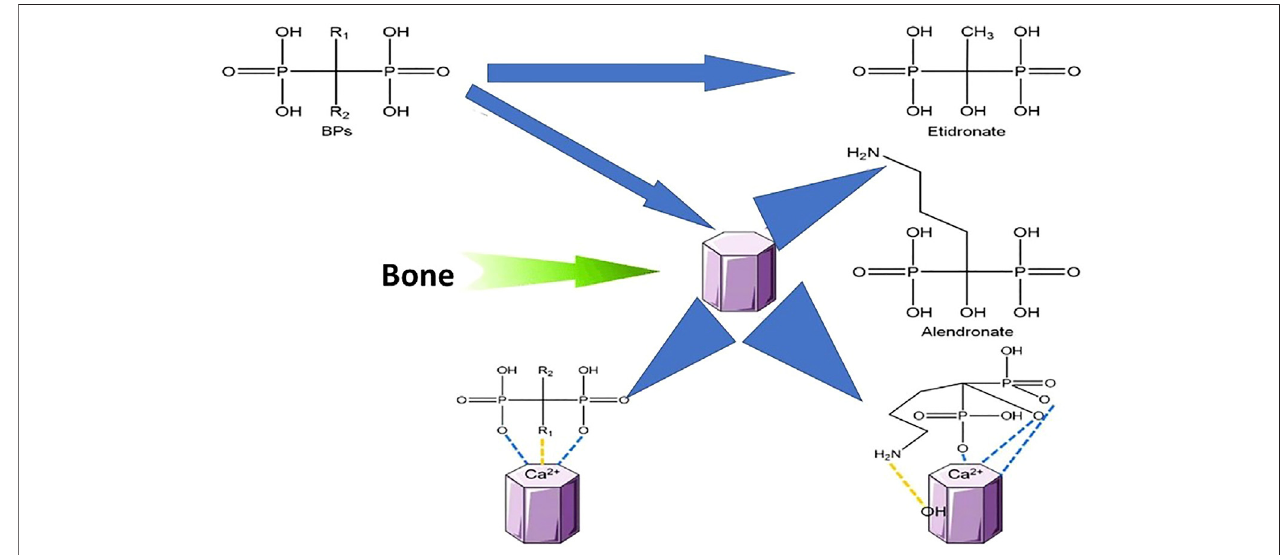
FIGURE 2 | Structure and binding mechanisms of nitrogen non-containing (etidronate) and containing (alendronate) bisphosphonates (BPs) with bone hydroxyapatite matrix.